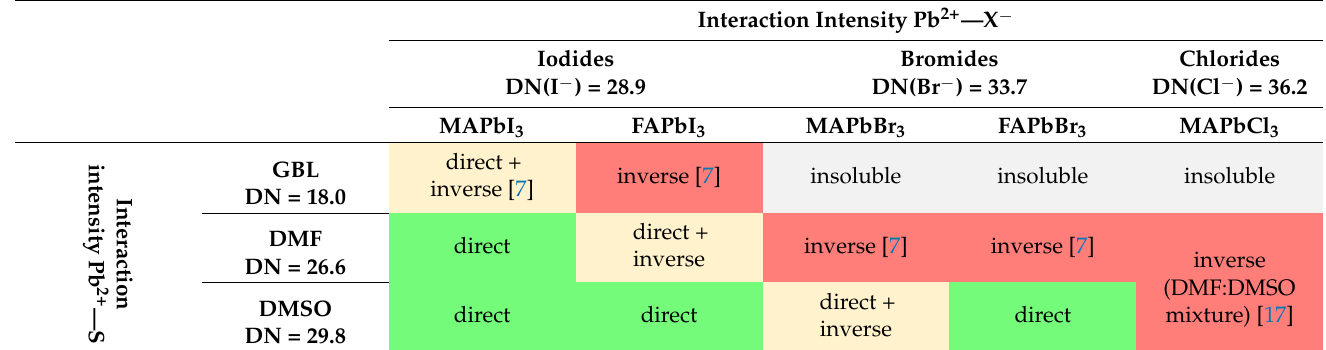
Table 1. Solubility behavior of hybrid perovskite depending on the solution